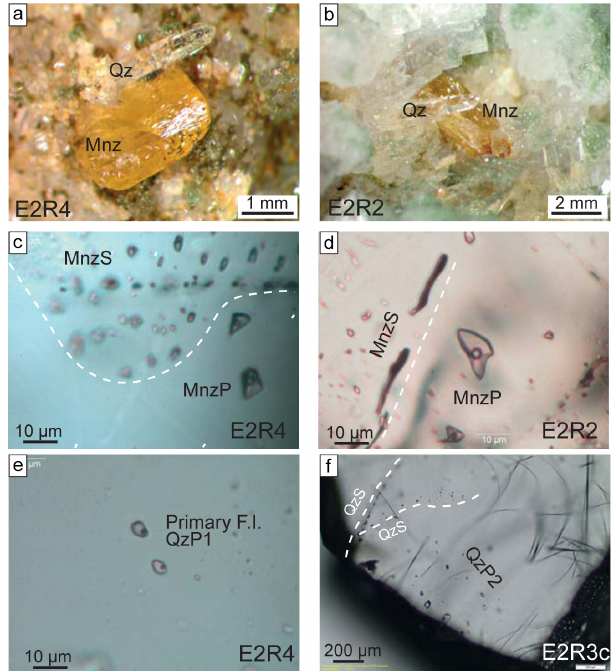
Figure 3. Photographs and microphotographs (c, d, e , f) of cleft quartz (Qz) and monazite (Mnz) crystals and their fluid inclusions. Photographs (a, b) show contiguous quartz and monazite crystals used for fluid inclusion microanalyses (samples E2R4 et E2R2, re- spectively). Microphotographs (c, d) show fluid inclusions in mon- azite; note that primary fluid inclusions (MnzP; around 10µm) are found in limpid domains whereas secondary fluid inclusions (MnzS; <5µm) form trails; microphotographs (e, f) show fluid inclusions in quartz: the two populations of primary inclusions (QzP1 and QzP2) have similar morphologies (euhedral with typical size of 10µm) and are found in limpid quartz domains, while the secondary fluid in- clusions are smaller and found aligned along trails. Black mineral fibres are meneghinite (Pb 13 CuSb 7 S 24 ; Moëlo et al., 2002).